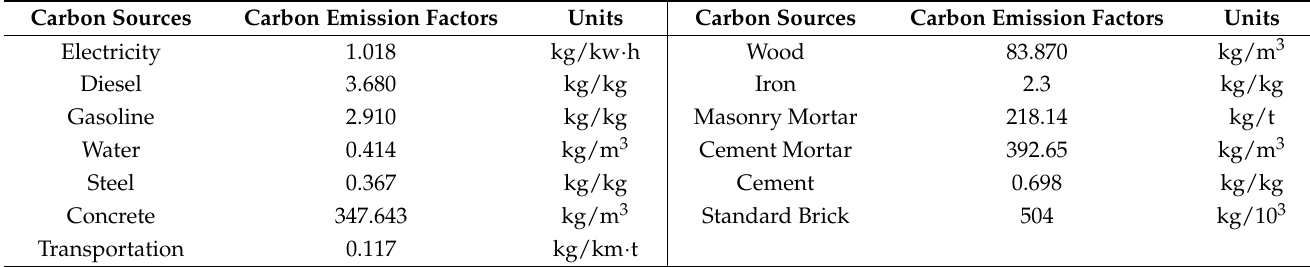
Table 2. Carbon Emission Factors of Major Materials and